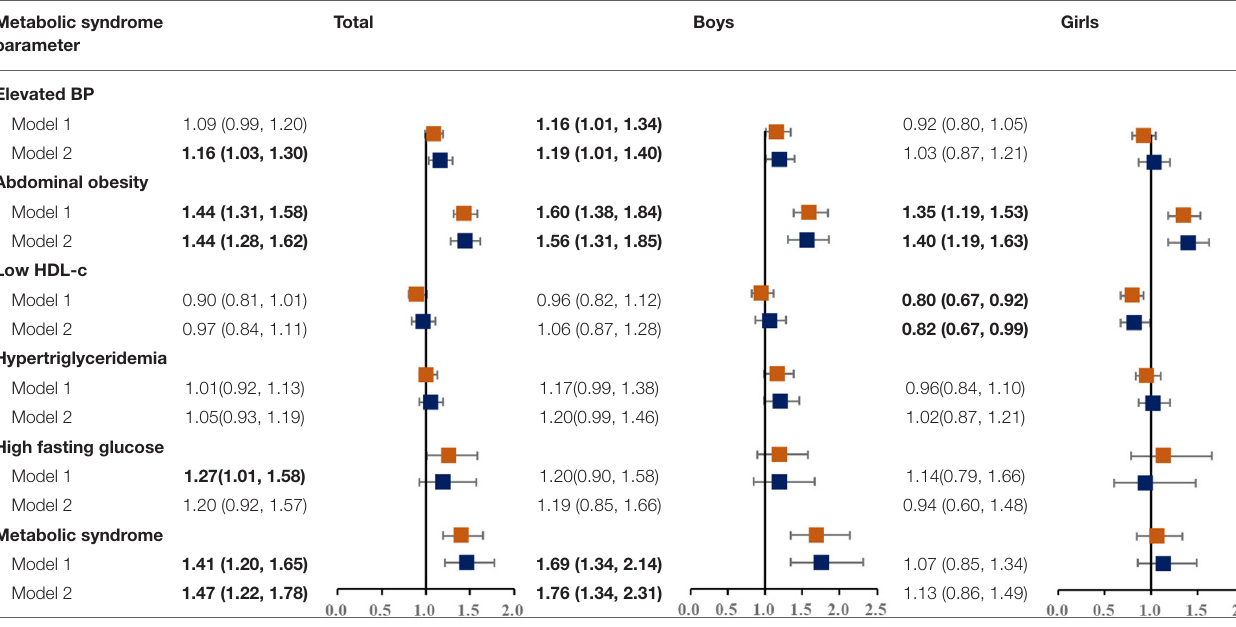
Model 1: adjusted for age, residence area. Model 2: adjusted for age, residence area, physical activity, fruits, vegetables, parental educational attainment, parental overweight/obesity, parental hypertension, parental diabetes mellitus. Bold values represent P <